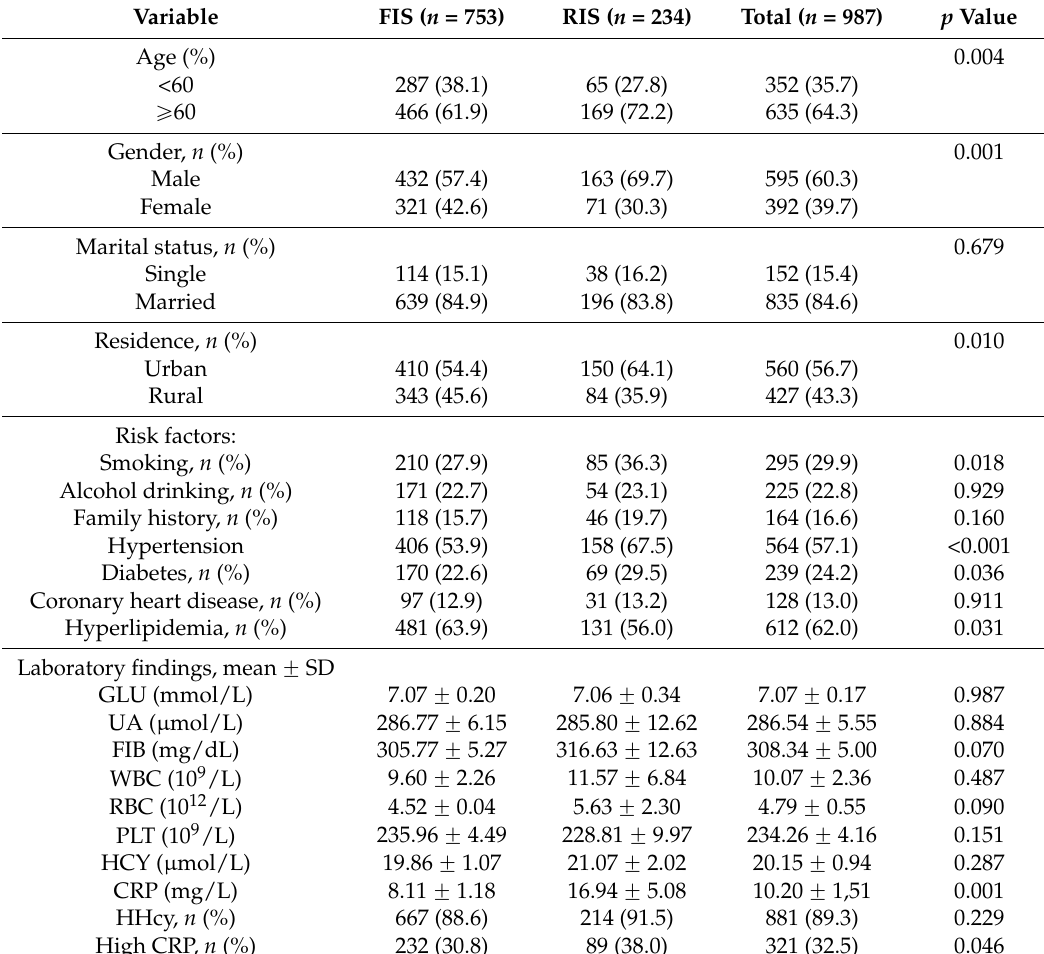
Table 1. Comparison of general information of patients with first-ever ischemic stroke (FIS) and recurrent ischemic stroke